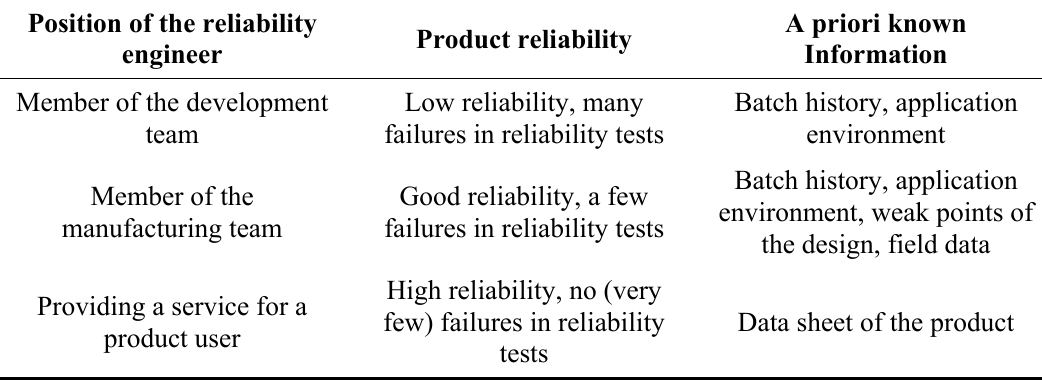
Table 1. Possible role of the reliability engineer vs. product reliability and a priori known